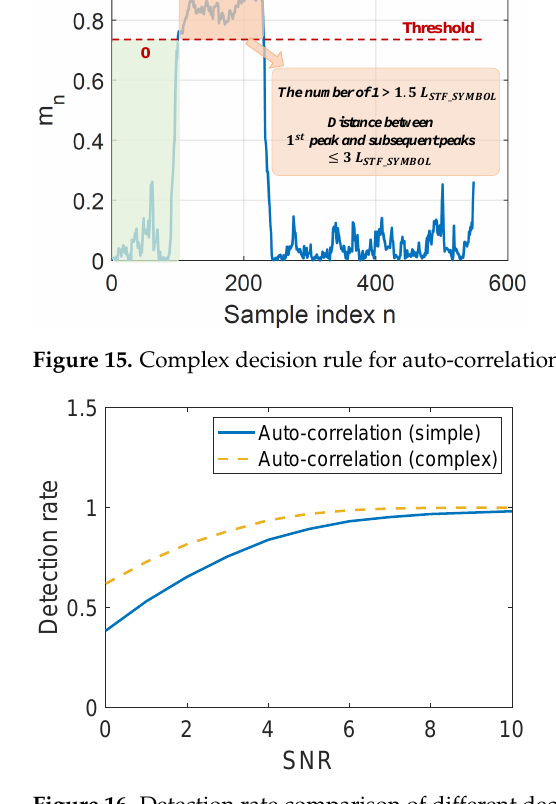
Figure 16. Detection rate comparison of different decision rules for